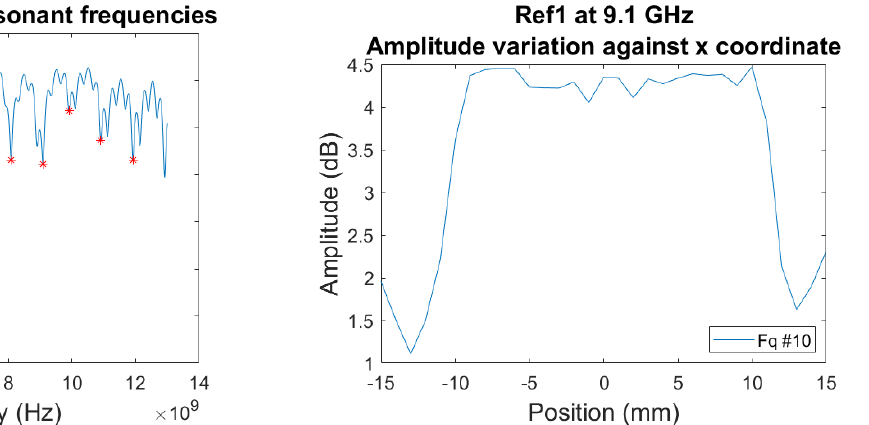
Figure 2. A typical microwave signal